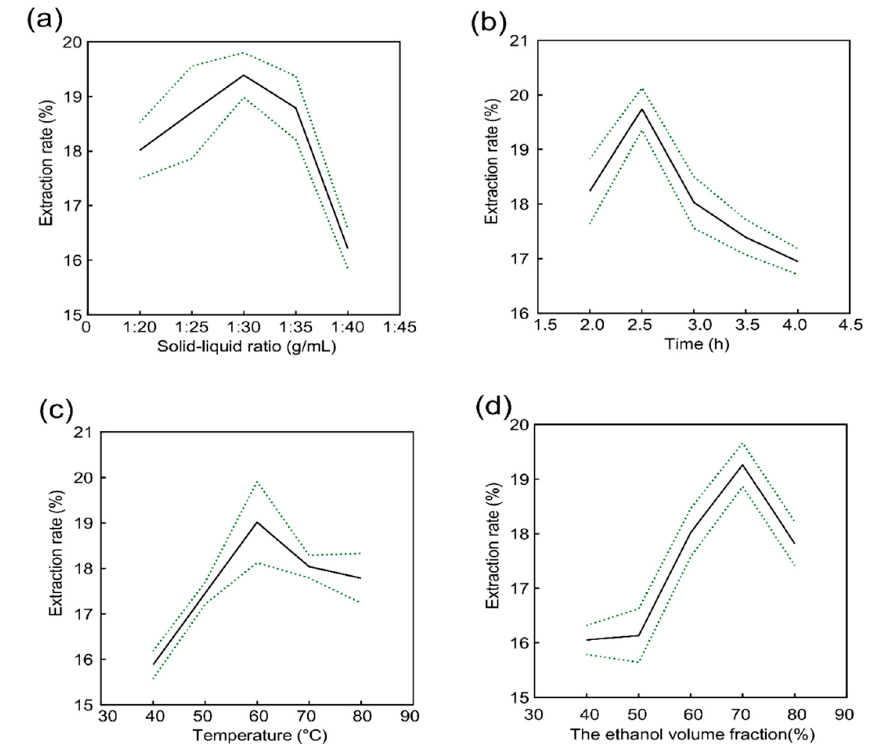
Figure 1. One-factor experiment results: ( a ) Effect of solid-to-liquid ratio on the extraction rate of BMF; ( b ) Effect of time on the extraction rate of BMF; ( c ) Effect of temperature on the extraction rate of BMF; ( d ) Effect of ethanol volume fraction on the extraction rate of BMF. The solid line represents the mean, and the dotted line represents the error line (Each value was represented as the mean ± SD of three independent experiments, n = 3).